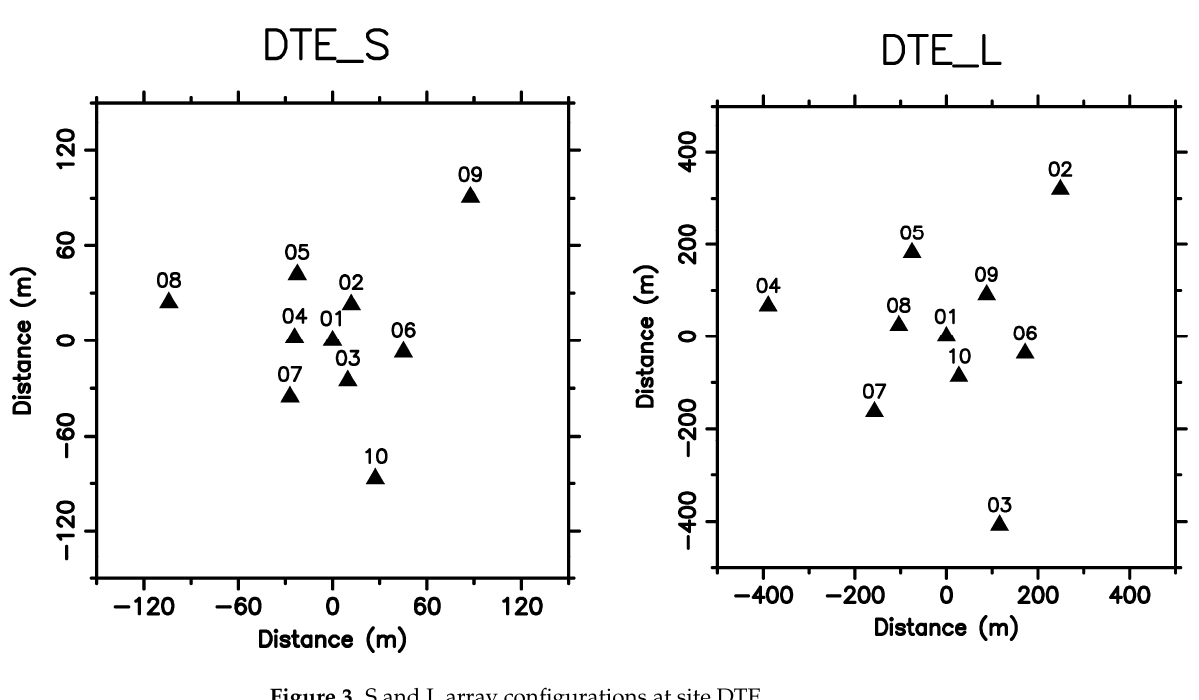
Figure 3. S and L array configurations at site